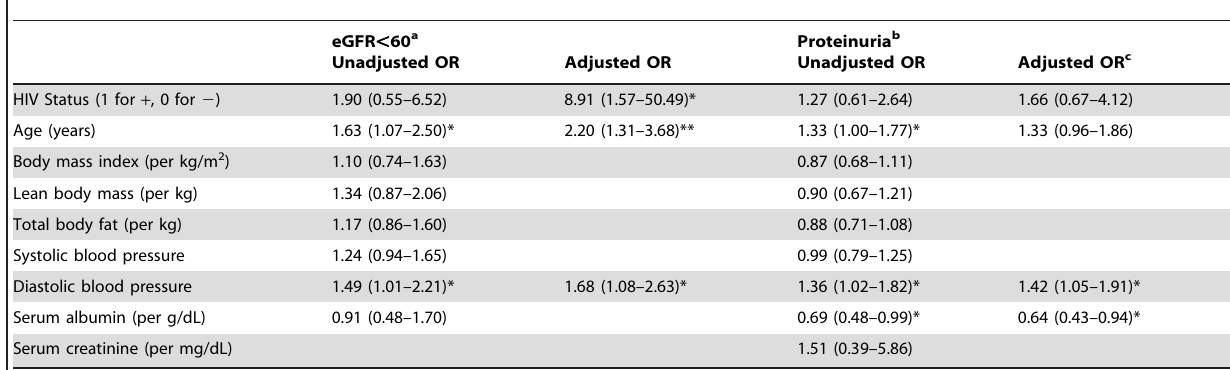
Table 3. Univariate and multivariate associations with kidney disease in all participants.